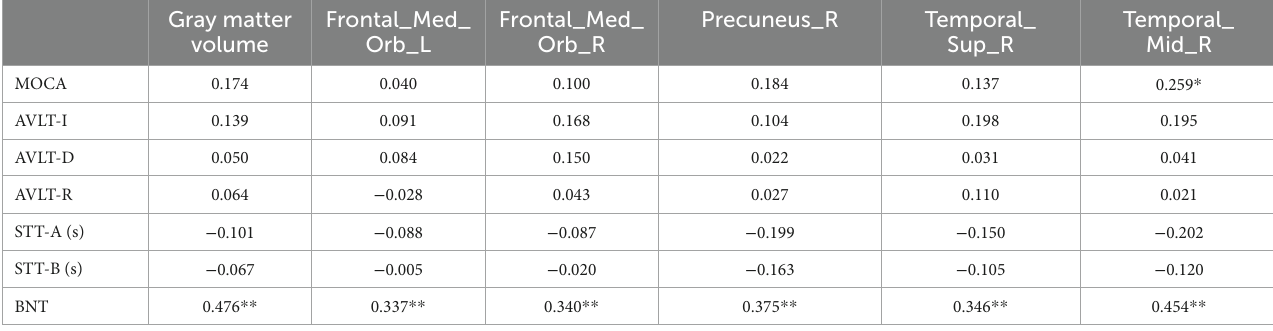
TABLE 5 Correlation analysis of gray matter volume and neuropsychological scale in the region of interest of the subcortical ischemic vascular disease- vascular cognitive impairment no dementia group. Gray matter